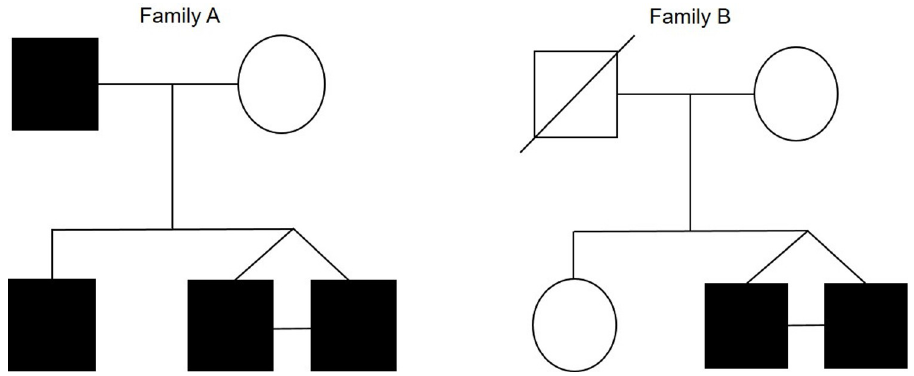
Fig 1. Pedigree structure for Family A and Family B with known history of surgically diagnosed non-contact anterior cruciate ligament (ACL) rupture. Circles indicate females, squares, males. Filled symbols indicate participants surgically diagnosed with non-contact anterior cruciate ligament rupture, and open symbols uninjured participants. Symbols with a line through them indicate deceased individuals.